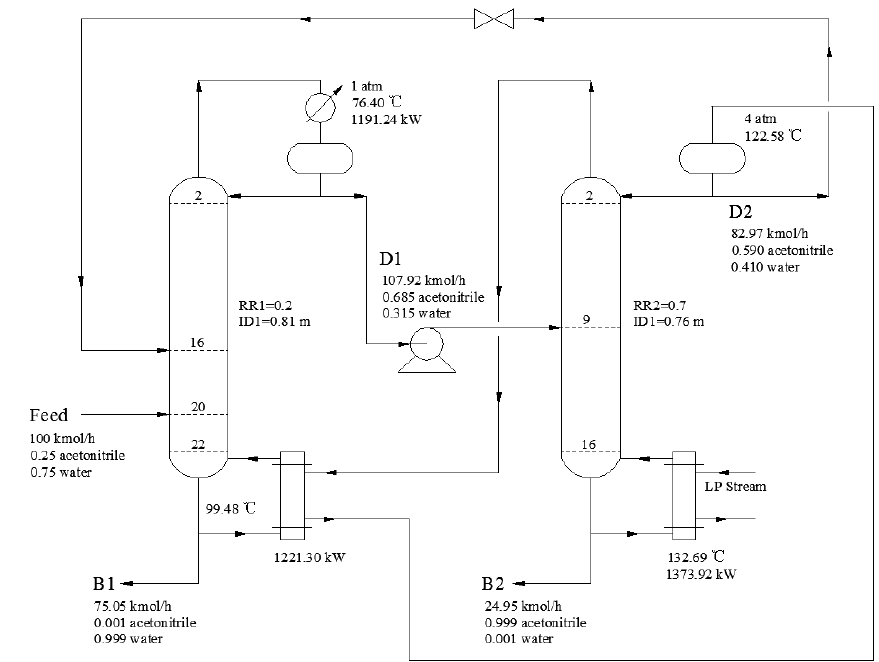
Figure 8. Optimized flow diagram of the pressure swing distillation (PSD) with full-heat integration.